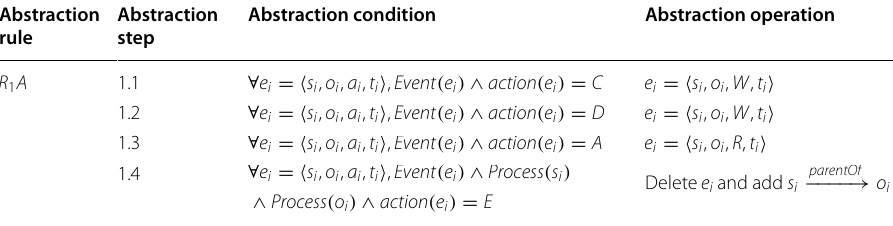
Table 5 Abstraction rules of actions